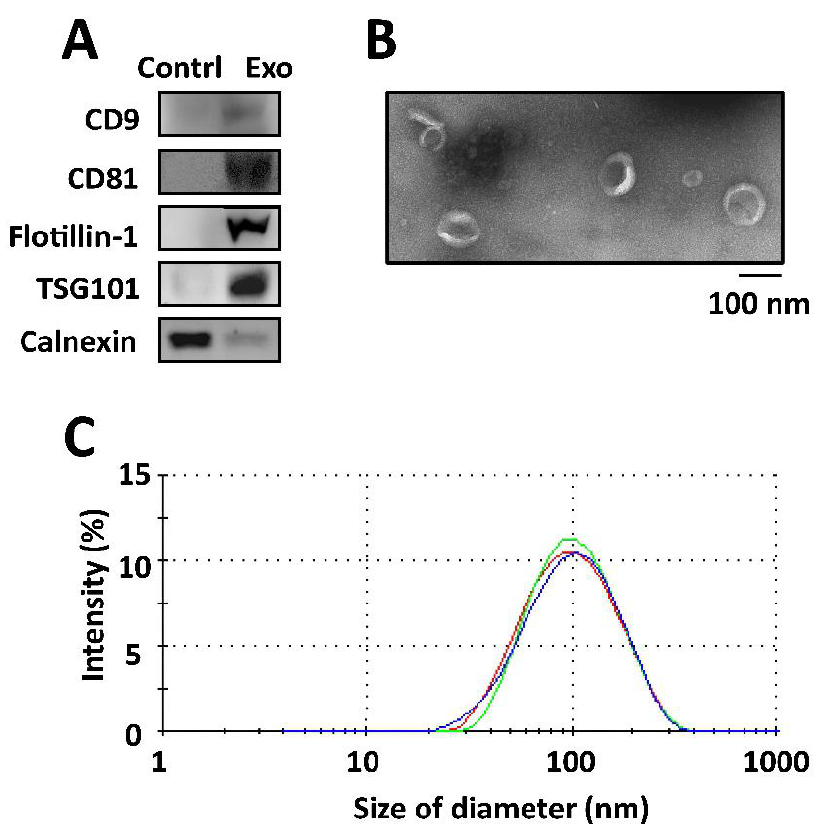
Figure 1. Characterization of exosomes isolated by ( A ) Western blotting for determining the exo- somal surface markers of those proteins isolated from the culture medium and exosomes secreted by ADSCs. The selected positive exosomal surface markers included CD9, CD81, flotillin-1, and TSG101. Expression of calnexin was detected as negative control protein for the isolation of exosomes. ( B ) Transmission electron microscopy image displaying a cup-shaped appearance of the exosomes with lipid bilayers, and ( C ) the measurement of particle diameter and size distribution by dynamic light scattering (DLS) in